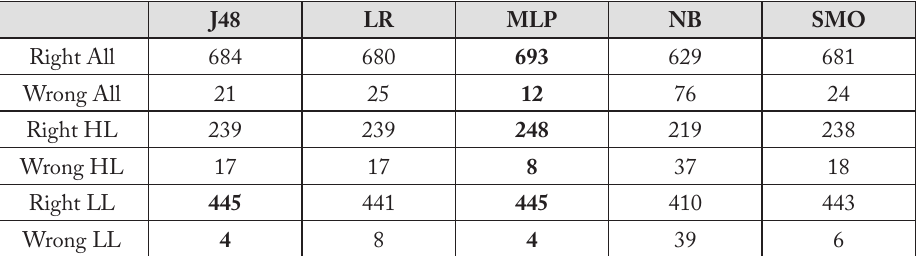
Table 4: Comparison of models’ performance on test dataset, based on correctly and incorrectly classified student